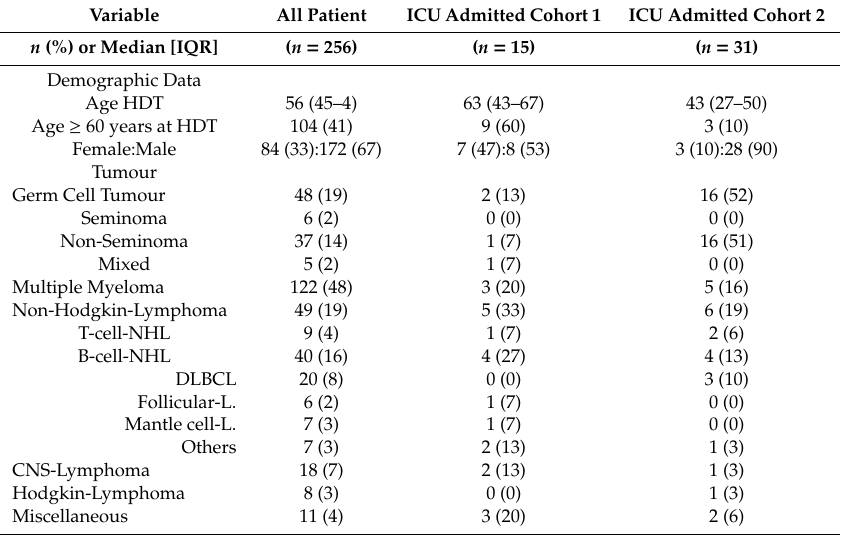
Table 1. Demographic data and cancer diagnosis of patients receiving high dose chemotherapy and subsequent autologous stem cell transplantation (ASCT). Cohort 1: patients admitted to the intensive care unit (ICU) due to immediate complications during high dose chemotherapy (HDT) and ASCT treatment. Cohort 2 patient admitted within 6 months after high dose chemotherapy and ASCT (excluding cohort 1